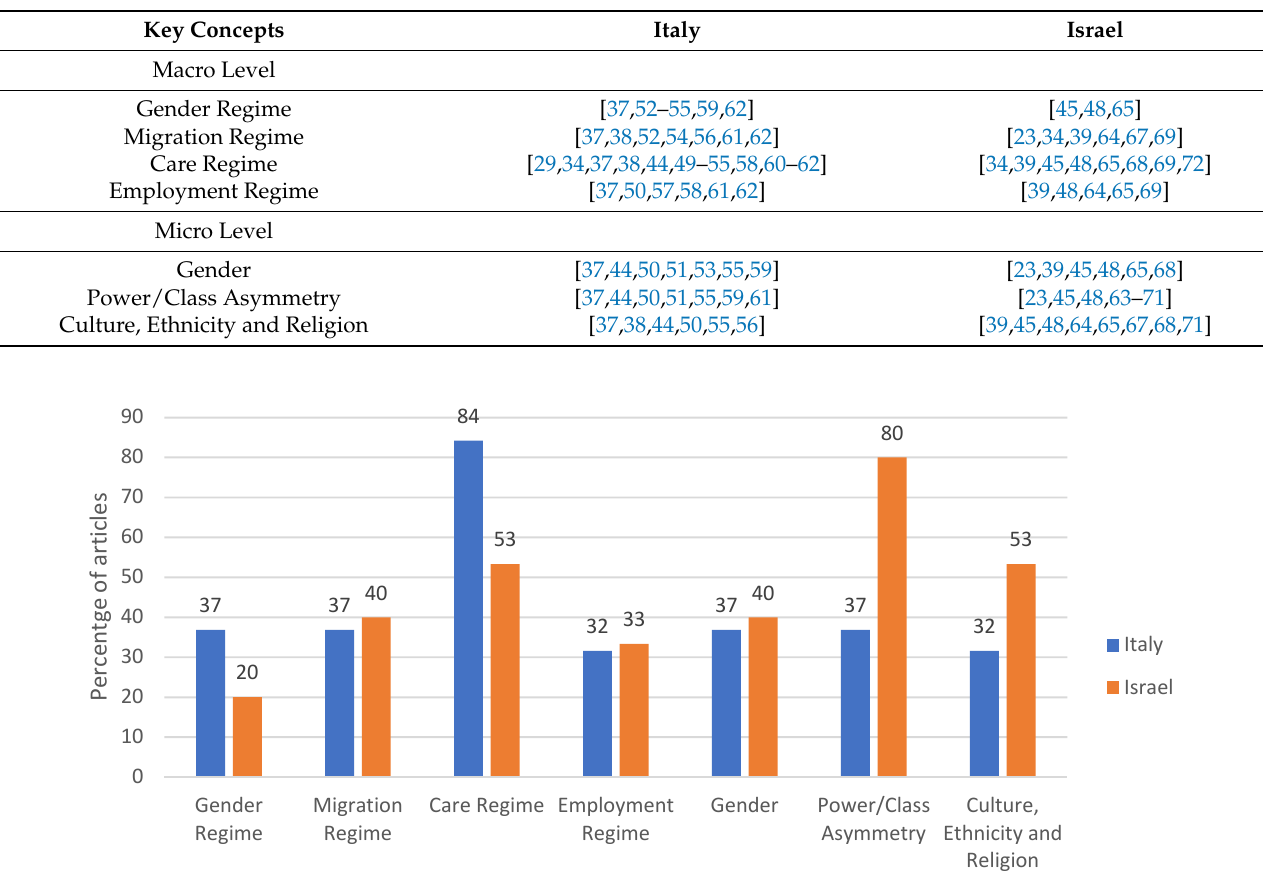
Table 2. Mapping of key concepts in reviewed articles.